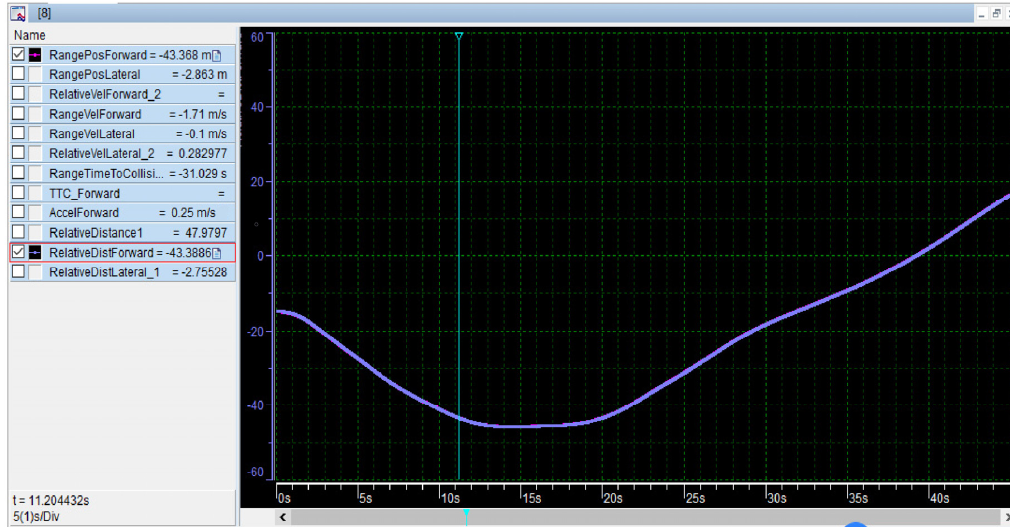
Figure 21. Relative_Dist_Forward of two